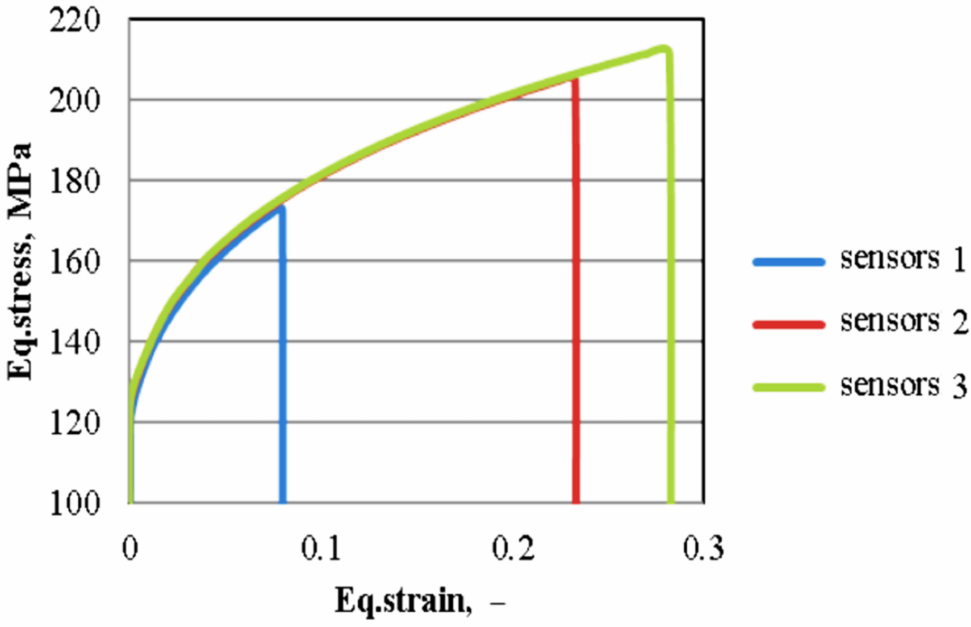
Figure 22. Stress-strain curves considering dry friction deformation